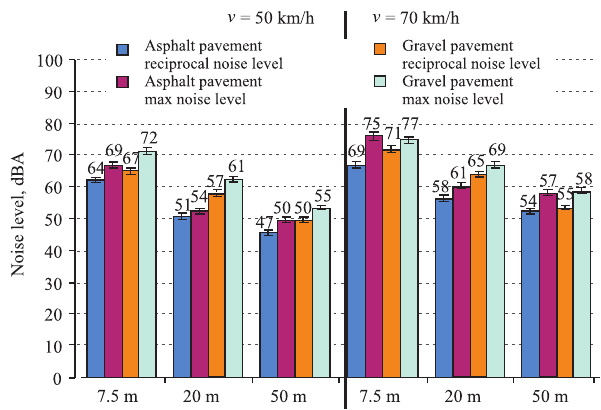
Fig. 9. Dependence of reciprocal and max noise levels on car speed when driving in an open area on road with asphalt and gravel pavement in summertime